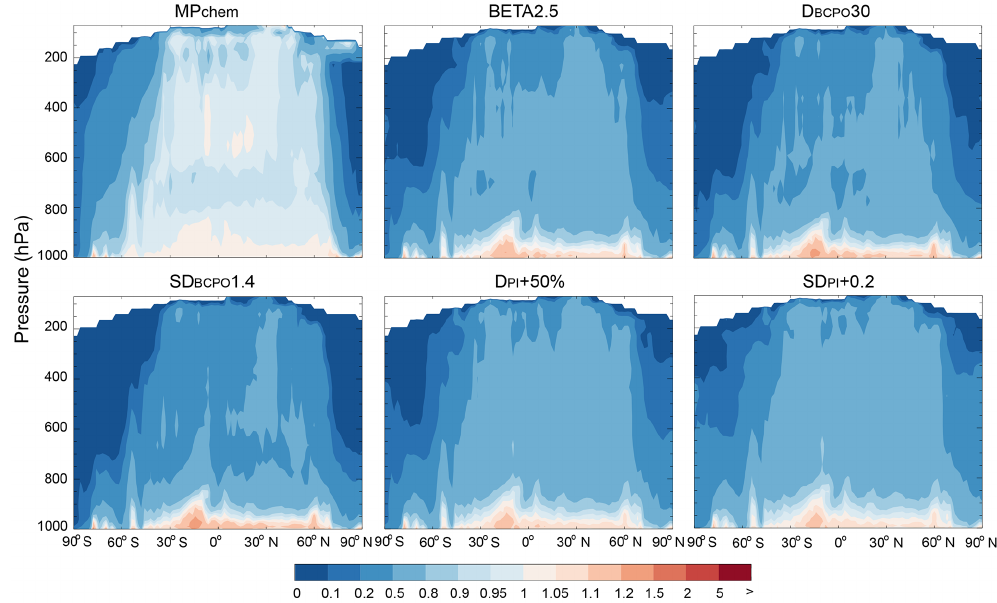
Figure 12. Same as Fig. 11 but for zonal mean BC aging